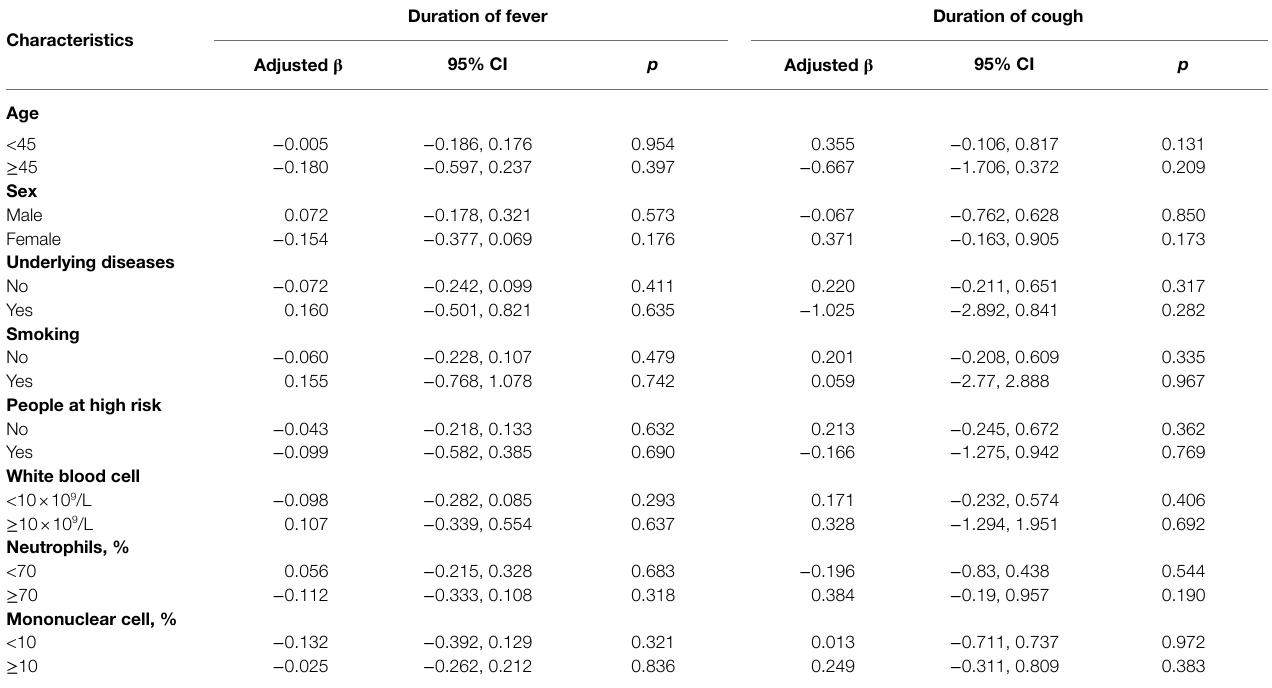
TABLE 5 | Outcomes of the duration days of fever for the ILI patients with or without the oseltamivir therapy.